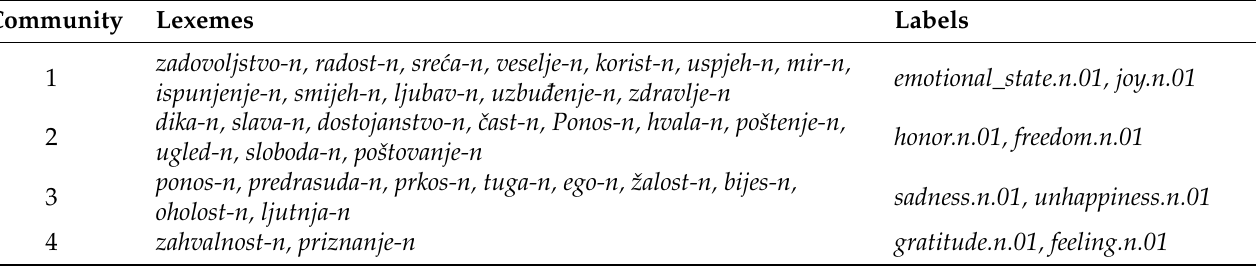
Table 3. Labels of semantic communities in lexical dependency graph of lexeme ponos-n calculated on hrWac22 corpus.